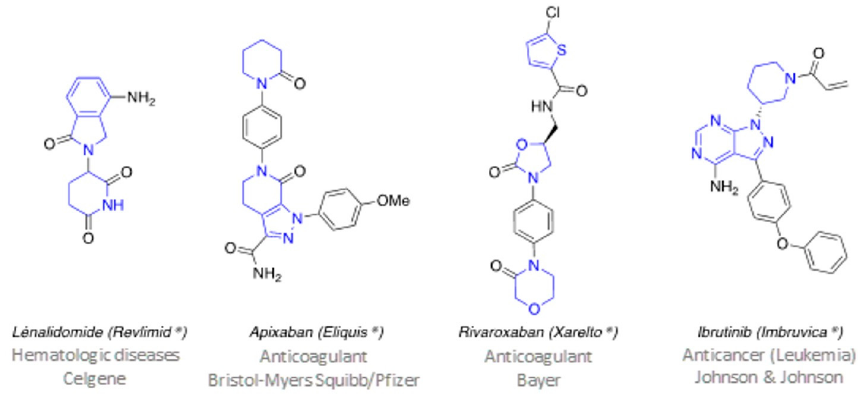
Figure 5. Recent big pharma’s blockbusters featuring key aza-heterocyclic